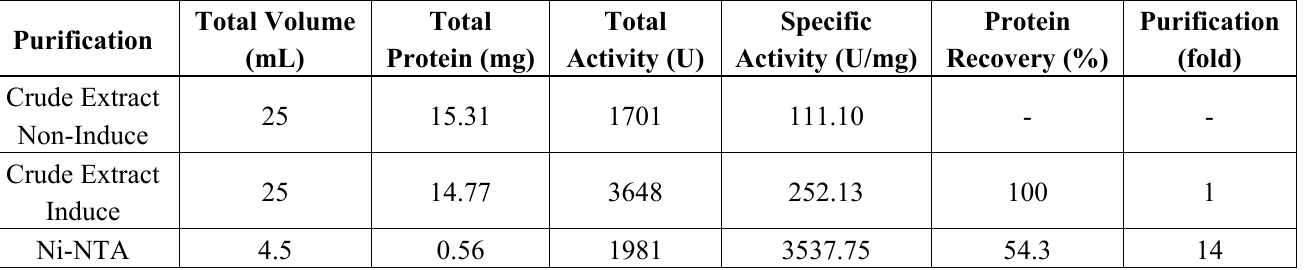
Table 1. Purification of